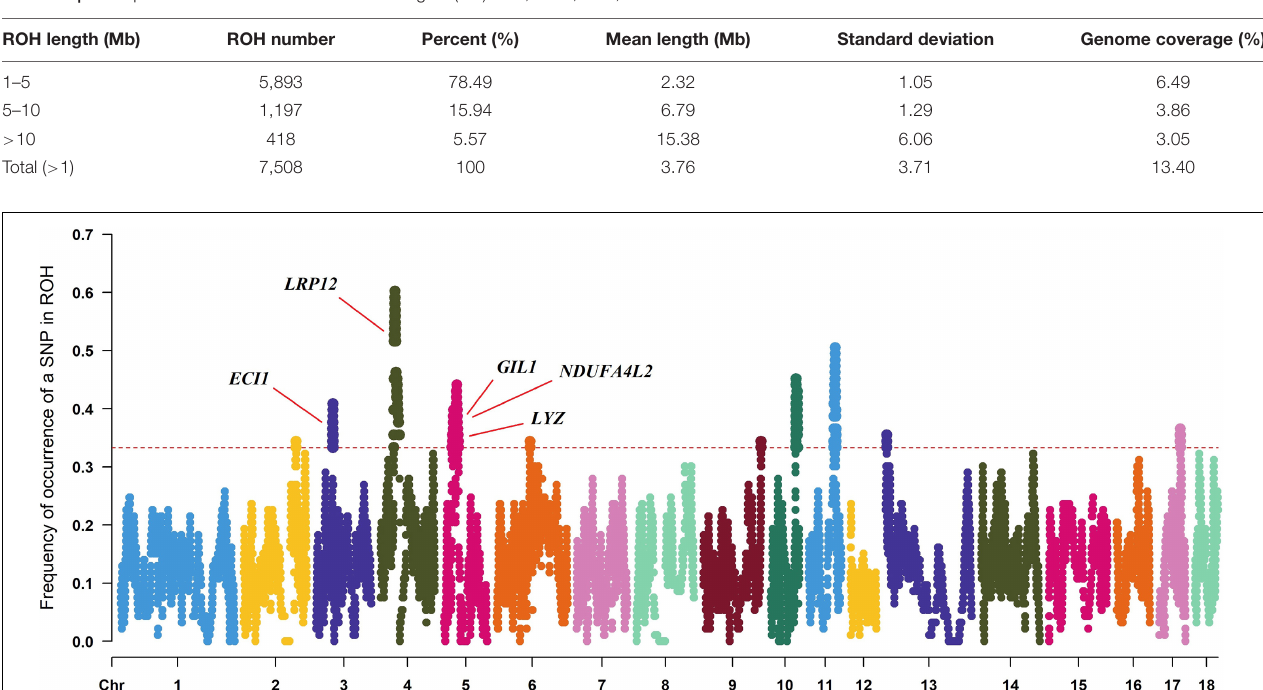
FIGURE 2 | Distribution of the ROH. (A) Length distribution of the ROH. X -axis represents the length of the ROH (Mb) using a base-10 log scale. Y -axis represents the number of ROH for different ROH lengths. (B) Bars and the red dotted line represent the number of ROH and the ROH coverage, respectively, on each chromosome. TABLE 3 | Descriptive statistics for ROH of different lengths (Mb): 1–5, 5–10, > 10, and > 1.